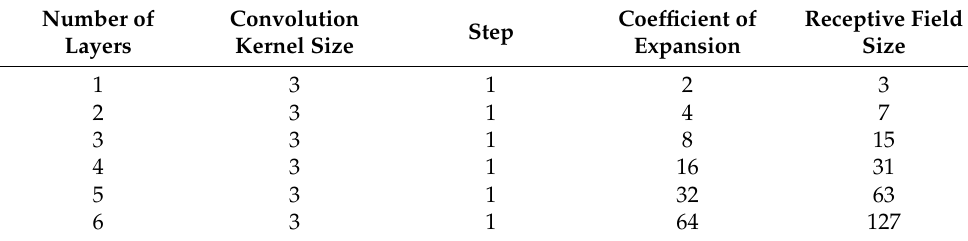
Table 1. Extended convolutional receptive field variation